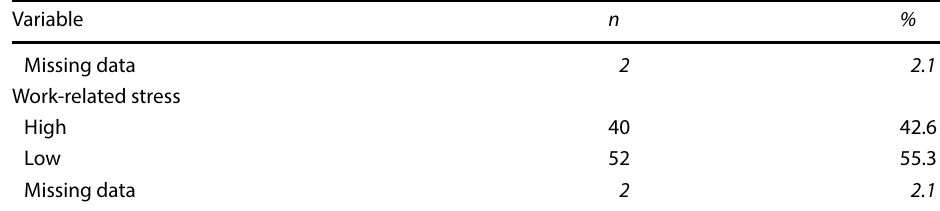
Table 2 Cross table of work category and return-to-work